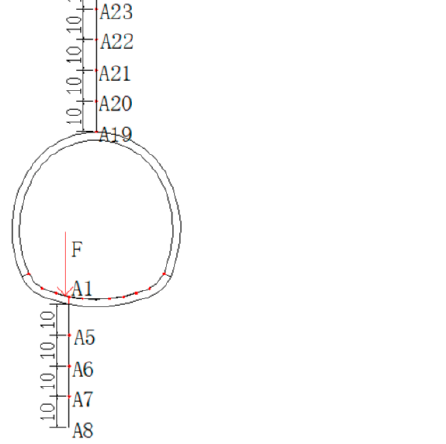
Figure 8. The layout of the acceleration sensor in the soil layer (cm).